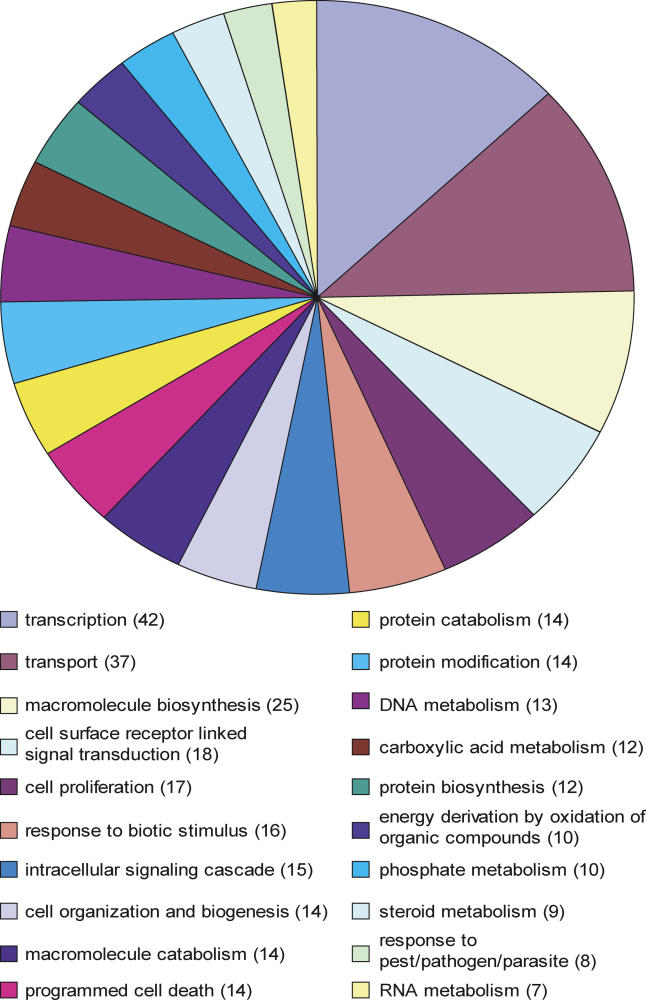
Functional Categories of the Genes Generated by Location AnalysisLocation analysis was performed using antiserum against the GR. Three treated and five control samples were amplified, fluorescently labeled, and hybridized to the Mouse PromoterChip BCBC-3.0 promoter microarray in a common reference design. Standard statistical methods identified 302 promoter regions significantly enriched in the treated samples compared to the fed controls (see Materials and Methods). The GO level 4 functional category for each gene was retrieved and the top 20 categories are shown. Note that some genes belong to multiple GO categories.